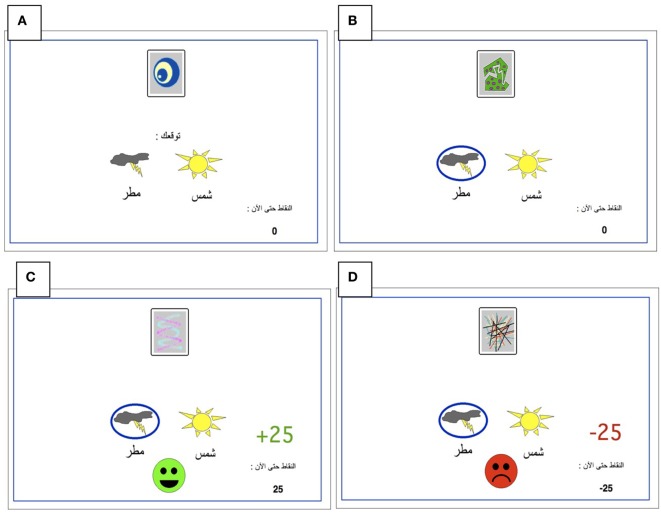
The Arabic-translated feedback-based probabilistic category task. (A) On each trial, the participant sees one of the four stimuli and is asked whether this stimulus predicts rain or sun. (B) No feedback is given for incorrect answers in positive feedback stimuli or correct answers in negative feedback stimuli. (C) For positive feedback stimuli, correct responses get rewarded with visual feedback and 25-point winnings. (D) For negative feedback stimuli, incorrect responses get punished with visual feedback and the loss of 25 points.